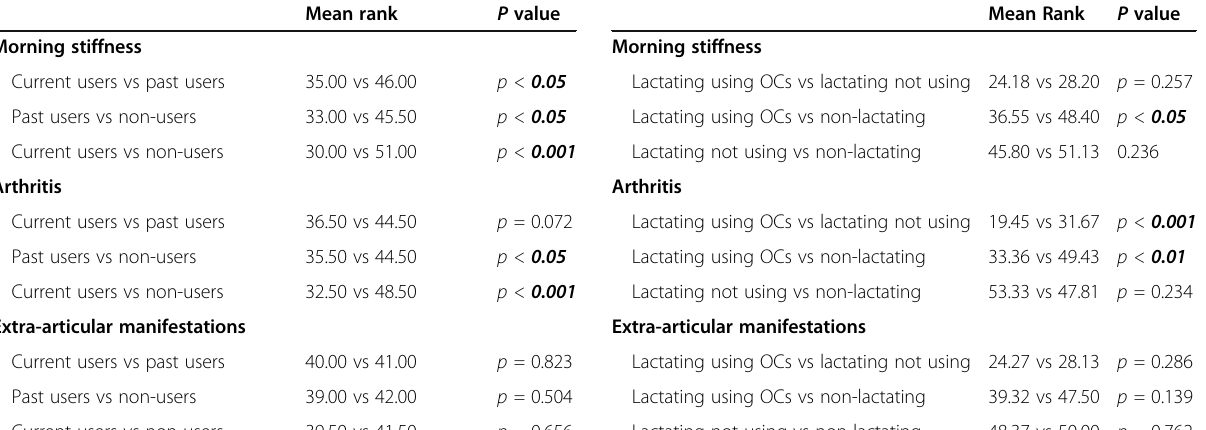
Current users vs non-users